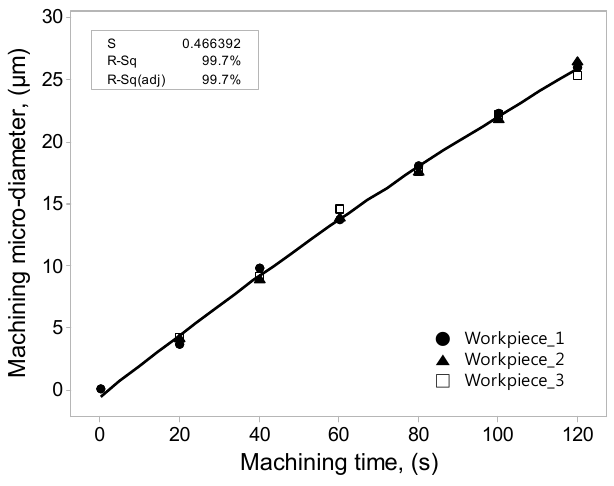
Figure 8. Regression analysis of the machining micro-diameter.